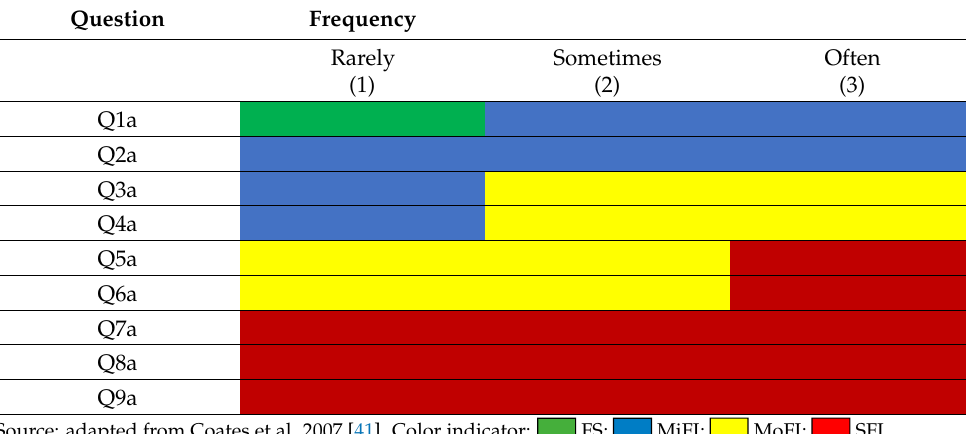
Table 2. Food insecurity